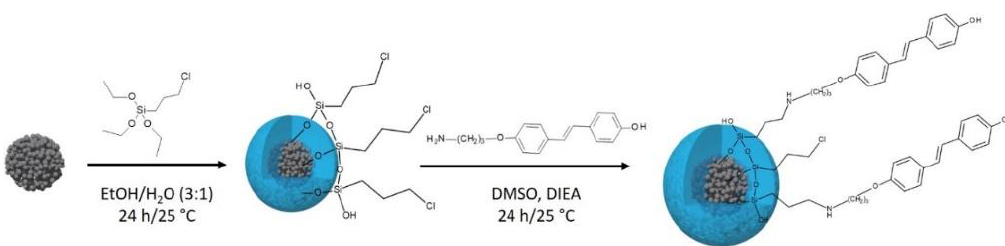
Figure 2. Schematic representation of the tran s-resveratol derivative-modified SPIONs Schematic representation of the trans -resveratol derivative-modified SPIONs (SPIONs-CPTES-HAPtS) nanohybrid synthesis. (SPIONs-CPTES-HAPtS) nanohybrid